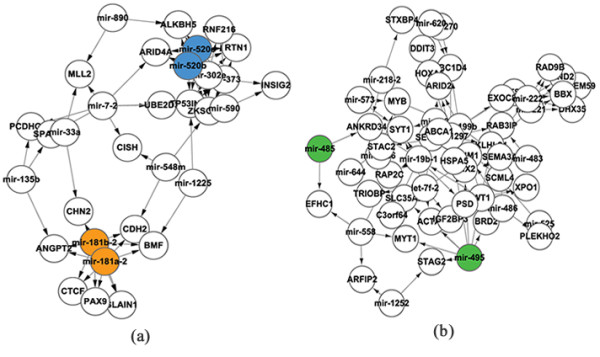
Clustered miRNAs in two examples of modules. a) A module containing homologous miRNAs from a homo-cluster (orange) and a hetero-cluster (blue); b) a module involving heterologous miRNAs from a hetero-cluster (green).